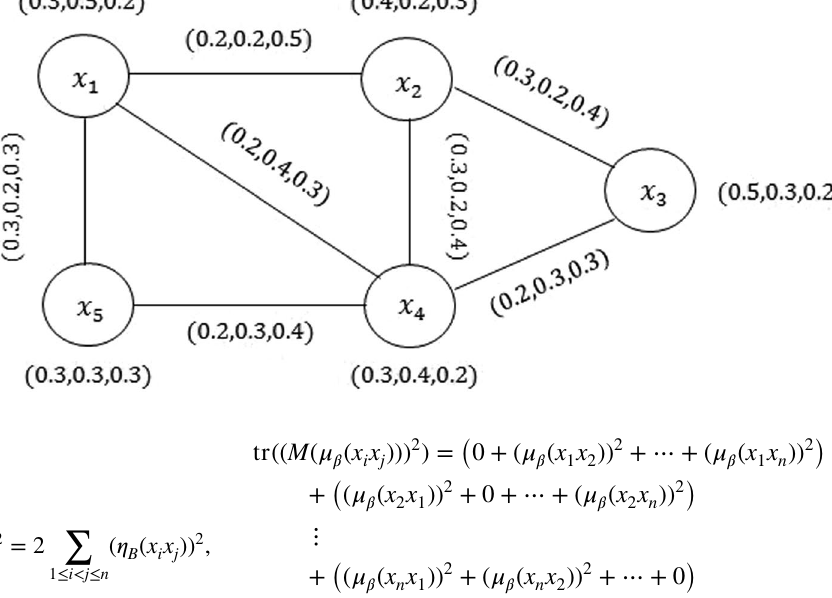
Fig. 2 PFG G = ( A , B